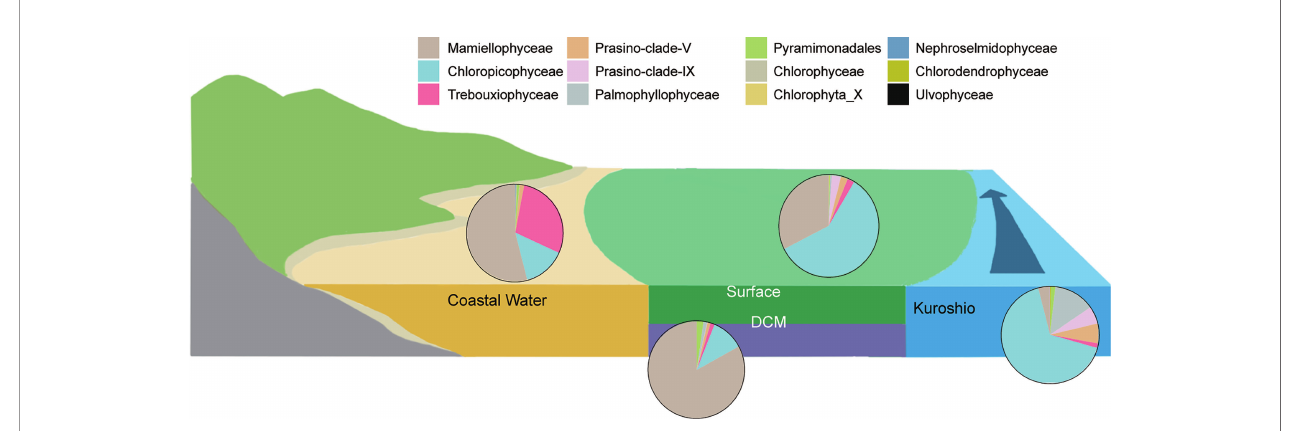
FIGURE 6 | A schematic showing currents and chlorophyte composition for each cluster in Figure 5 . Earthy yellow and gray blue indicate the coastal currents and offshore Kuroshio water, respectively. These two waters mixed on the shelf region over the East China Sea. The pie charts represent the average proportion of total chlorophyte composition in each cluster (in Figure 5 ) at the “ class ” level